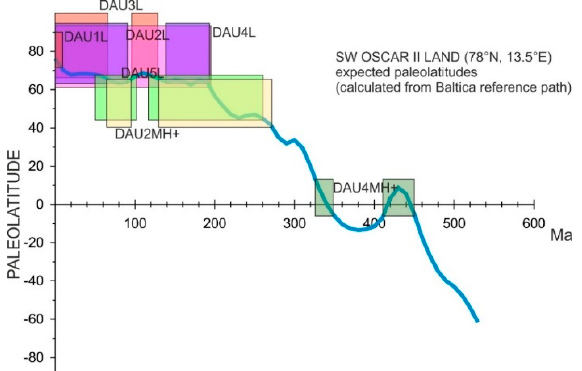
Figure 12. Palaeolatitudes of Western Terrane of Svalbard ( sensu Harland 1997 [26]) during magnetization of palaeomagnetic components identified in metadolerites of SW Oscar II Land; palaeolatitude curve for Oscar II Land sampling area (78° N, 13.5° E) has been calculated from Baltica APWP, derived from GMAP 2012 palaeopoles libraries [48]; all palaeolatitudes of investigated area are recalculated for northern hemisphere and are presented with confidence limits defined by Dp (half-axis of palaeopole oval of the confidence limit α 95).